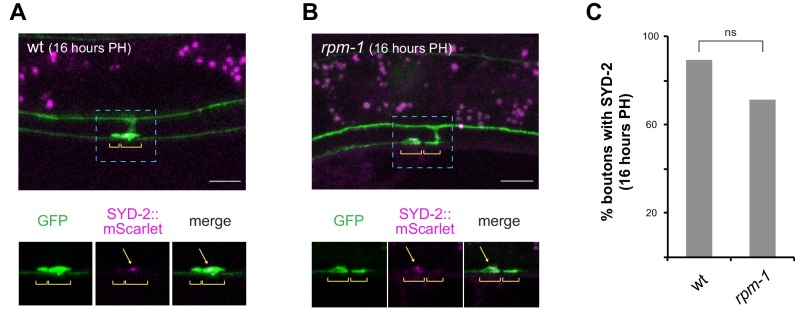
SYD-2 active zone marker accumulates in rpm-1 mutants at 16 hr PH.(a) Confocal image showing SYD-2::mScarlet localizes to presynaptic boutons in PLM neurons of wt animals. Top image is merged maximum projection. Bottom images are single confocal slices showing SYD-2::mScarlet (red) and presynaptic bouton (GFP). Note, SYD-2 is visible in the PLMR but not PLML because SYD-2::mScarlet was expressed as an extrachromosomal array which displays mosaicism. (b) In rpm-1 mutants, we observe SYD-2::mScarlet at presynaptic boutons. (c) Quantitation of PLM presynaptic boutons containing SYD-2 for indicated genotypes. Significance tested using Fisher’s exact test. Scale bars are 5 µm.